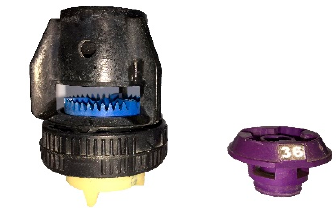
Figure 1. Nelson D3000 sprinkler .